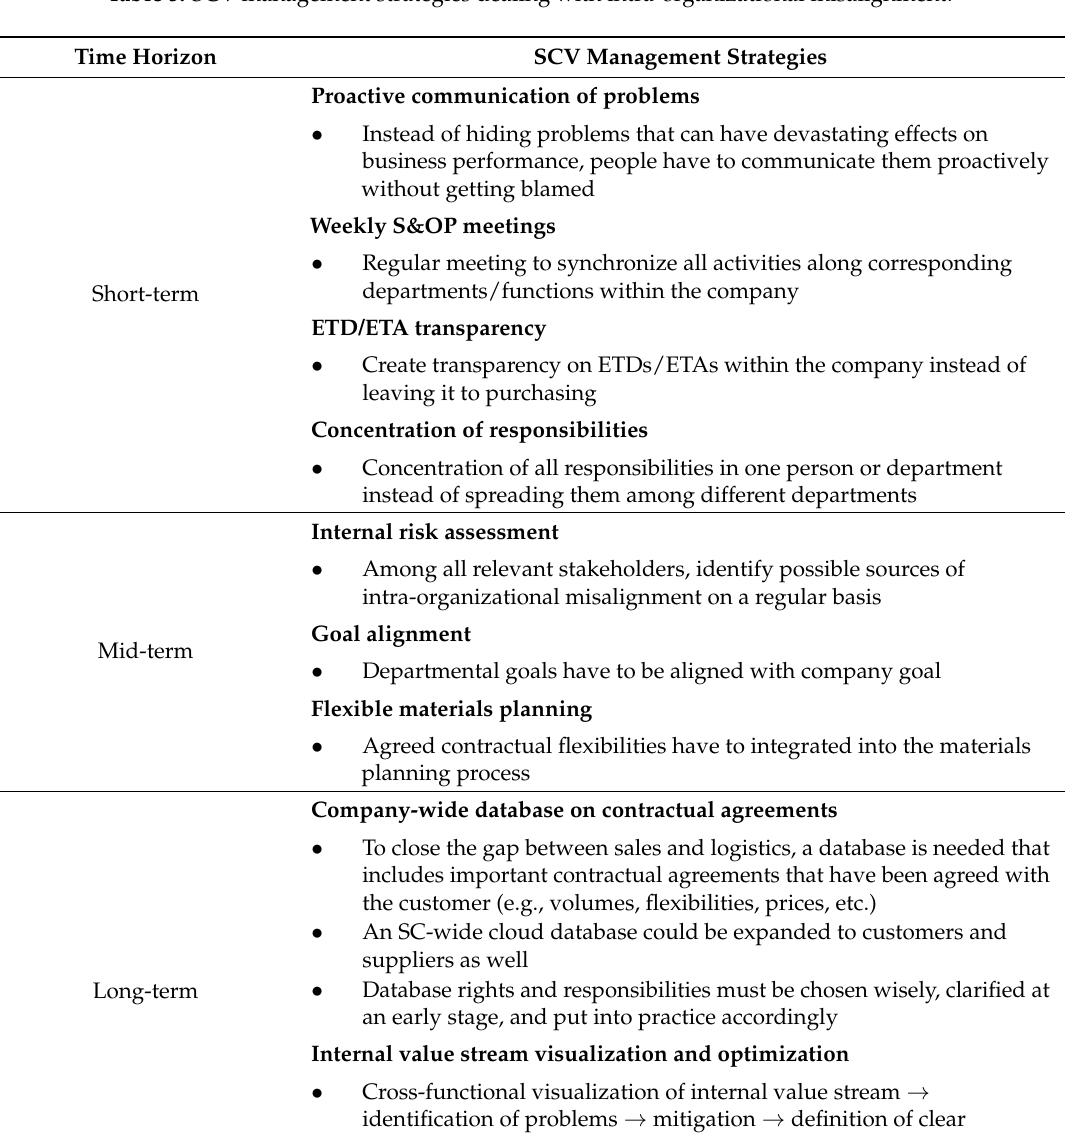
Table 5. SCV management strategies dealing with intra-organizational